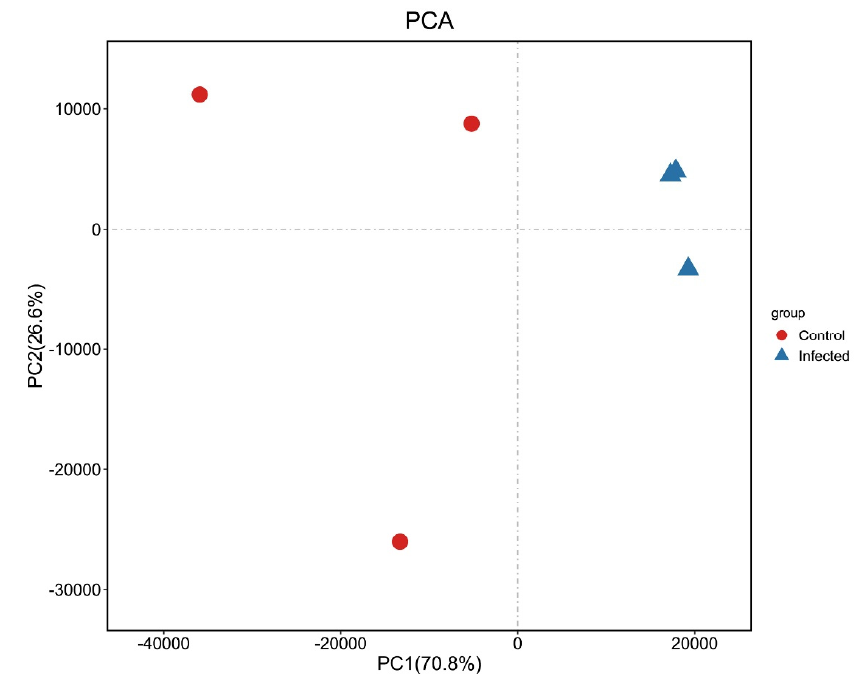
Figure 2. PCA of transcriptome samples. Abscissa PC1 and ordinate PC2 represent the scores of the first and second principal components, respectively. Scatter points of different colors represent samples belonging to different groups.